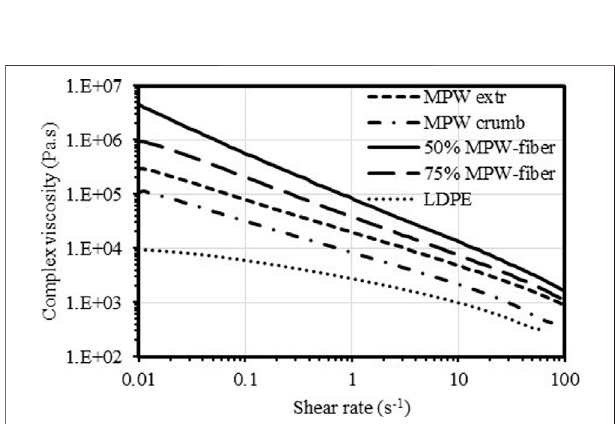
FIGURE 10 | Flow curves (complex viscosity vs shear rate) at 180 ° C of extruded MPW, extruded MPW- fi ber (50/50 and 75/25), compression molded MPW crumb and